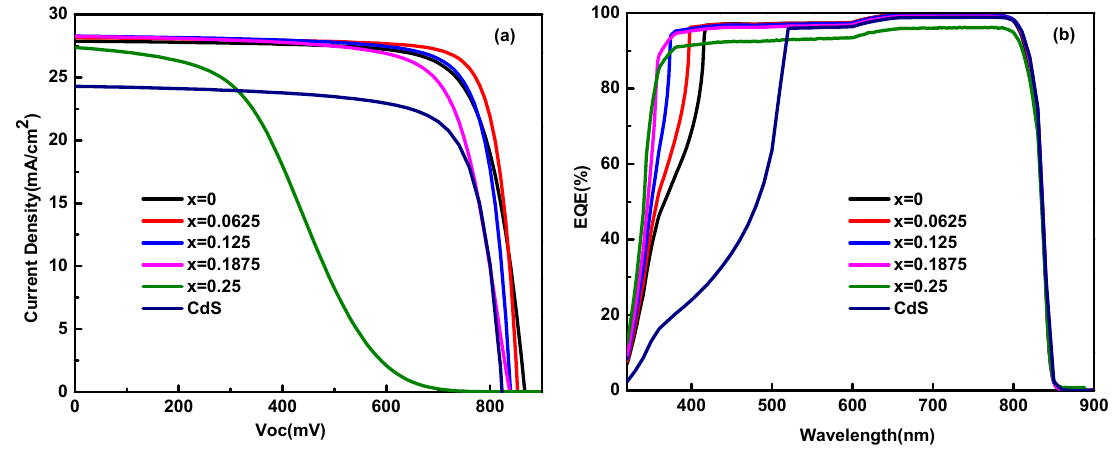
Figure 6. ( a ) J ‐ V curves and ( b ) external quantum efficiency of CdTe solar